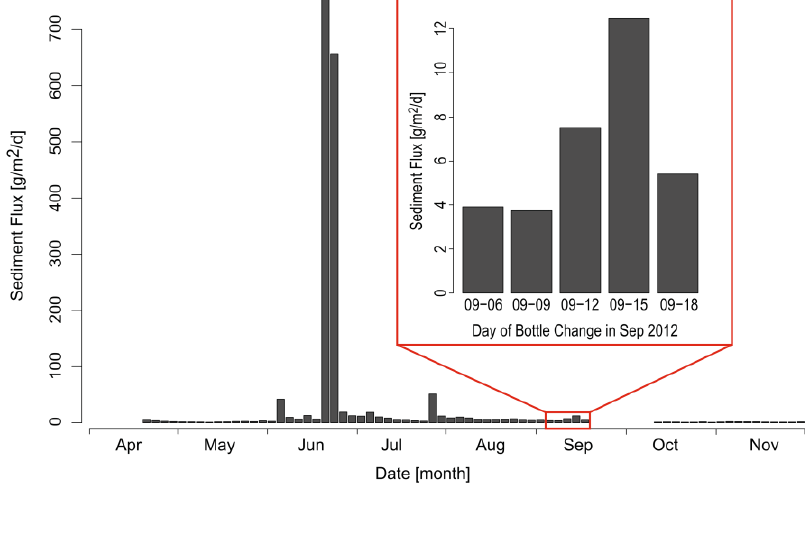
Figure 8. Sedimentation rates from a Technicap PPS4/3 sediment trap working sequentially with a temporal resolution of three days. Sedimentation rates are shown from April to November 2012. The red frame highlights the sedimentation rated during the flood